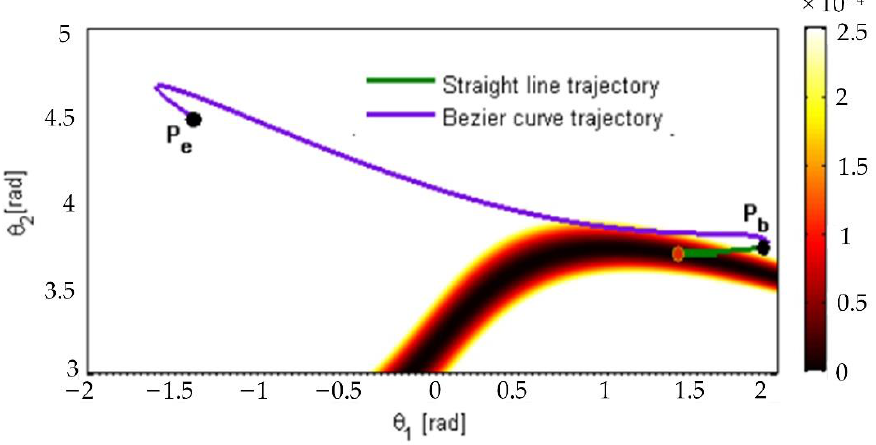
Figure 8. Comparison of a line trajectory and a trajectory based on a Bézier curve in joint space.